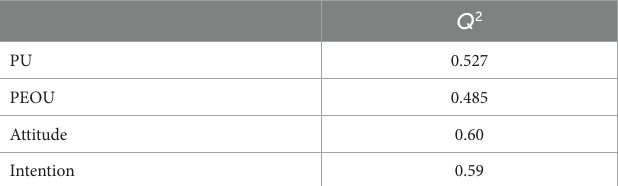
TABLE 6 Cross-validated redundancy of